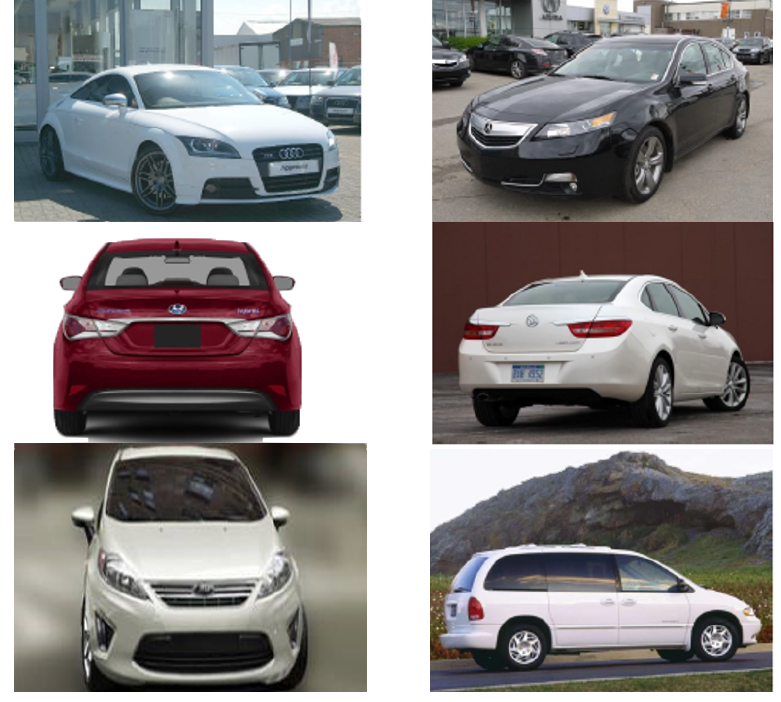
Figure 3. Example of vehicle images.